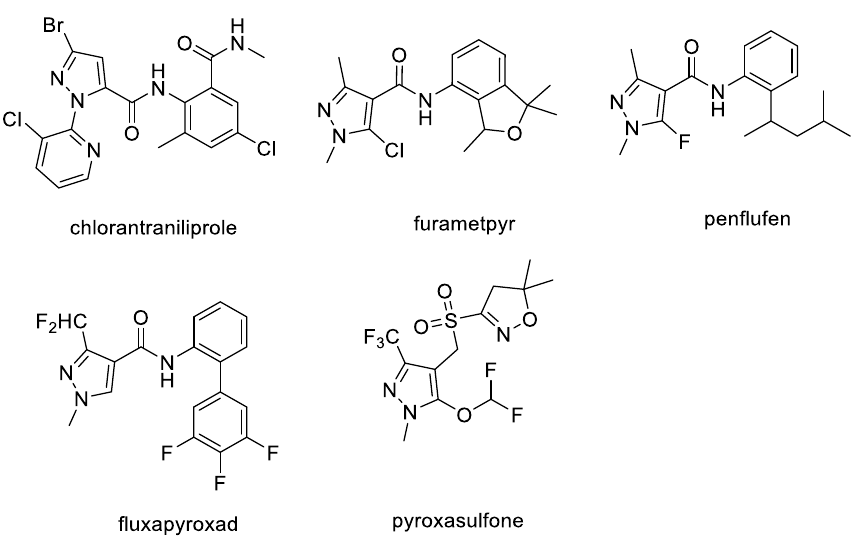
Figure 1. Structures of the reported pyrazole-containing compounds [9,19].